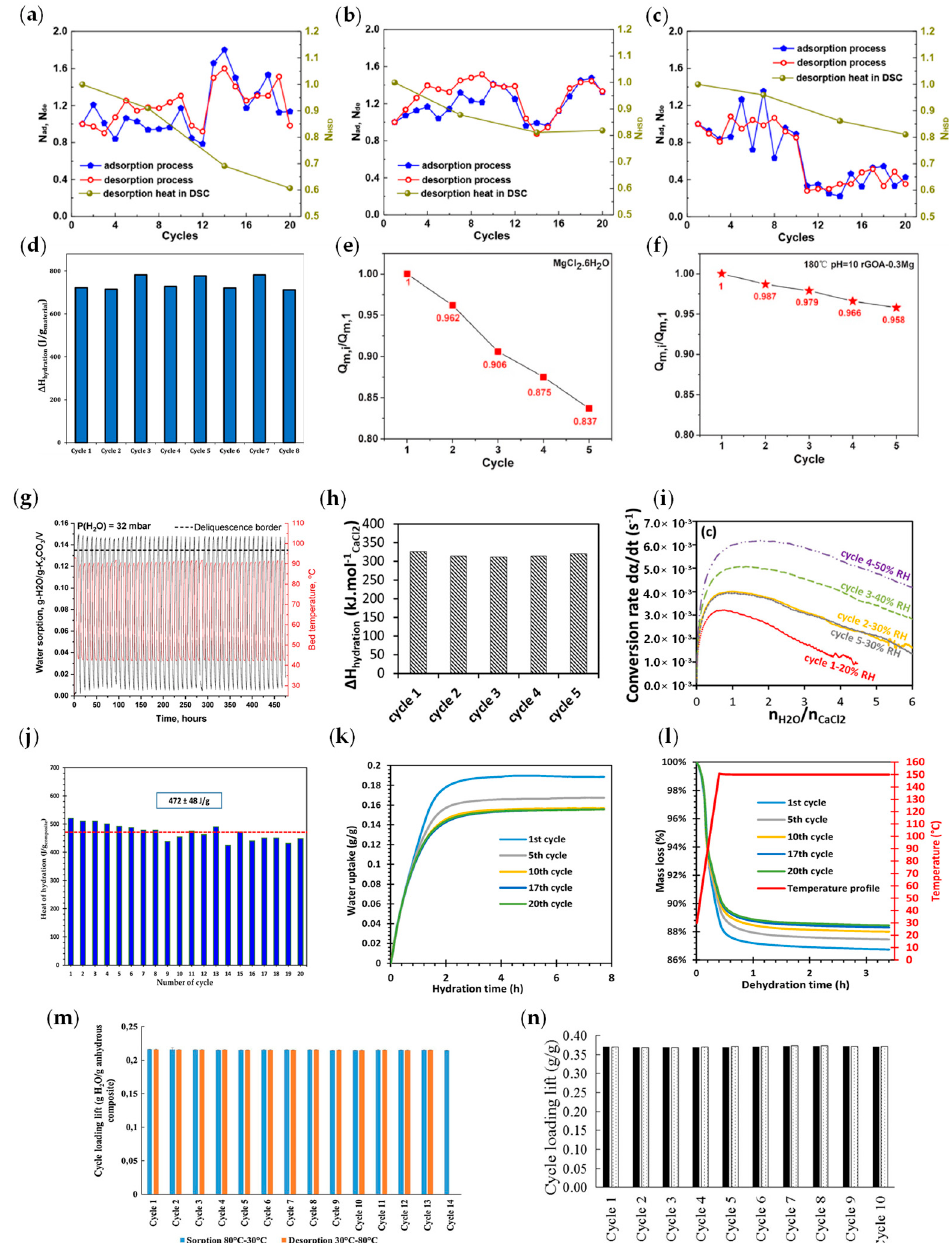
Figure 19. Cycle stability of composites: ( a ) CaCl 2 :MgSO 4 = 6:4 [110], ( b ) Zeolite 13X: CaCl 2 :MgSO 4